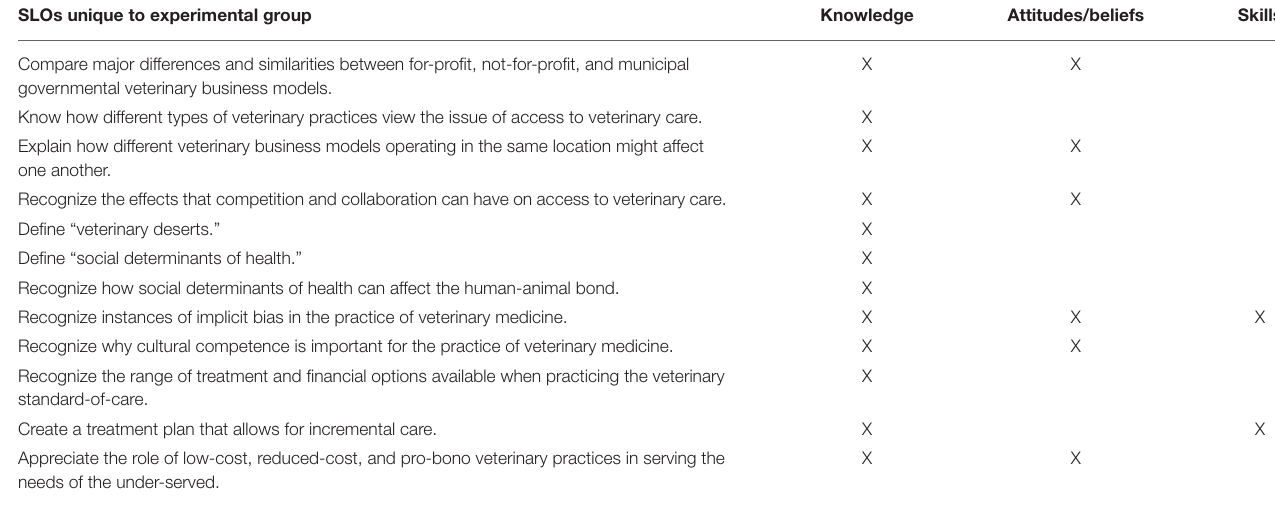
SLOs unique to experimental group Knowledge Attitudes/beliefs